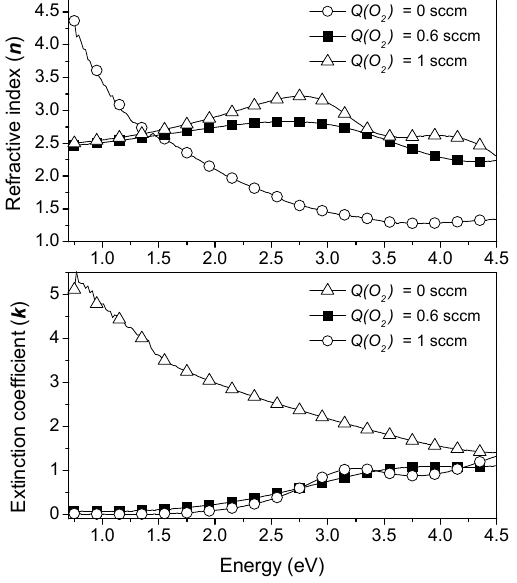
Figure 9. Effect of the oxygen flow rate on the refractive index and extinction coefficient of Fe-O-N films deposited with Q (N 2 ) = 8 sccm.